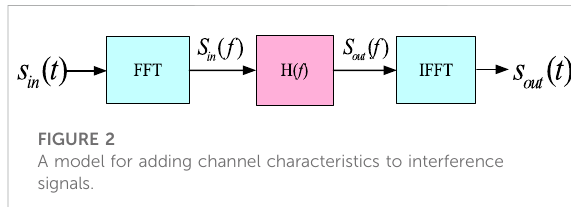
FIGURE 2 A model for adding channel characteristics to interference